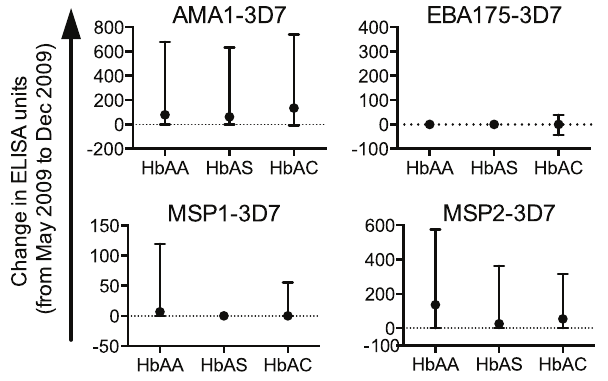
Figure 4. Increases in merozoite antigen-specific IgG levels during a transmission season do not differ by Hb type. For each child, the change in IgG level from May to December 2009 was calculated for each antigen (A, AMA1-3D7; B, MSP1-3D7; C, EBA175-3D7; D, MSP2-3D7). All responses below the limit of detection (44 ELISA units) were assigned a value of 22 ELISA units. Median and interquartile range are shown. Positive values represent increases in IgG levels at the end of the transmission season. Changes in IgG levels were not significantly different among the three Hb types for any antigen (p . 0.05 by Kruskal-Wallis tests).